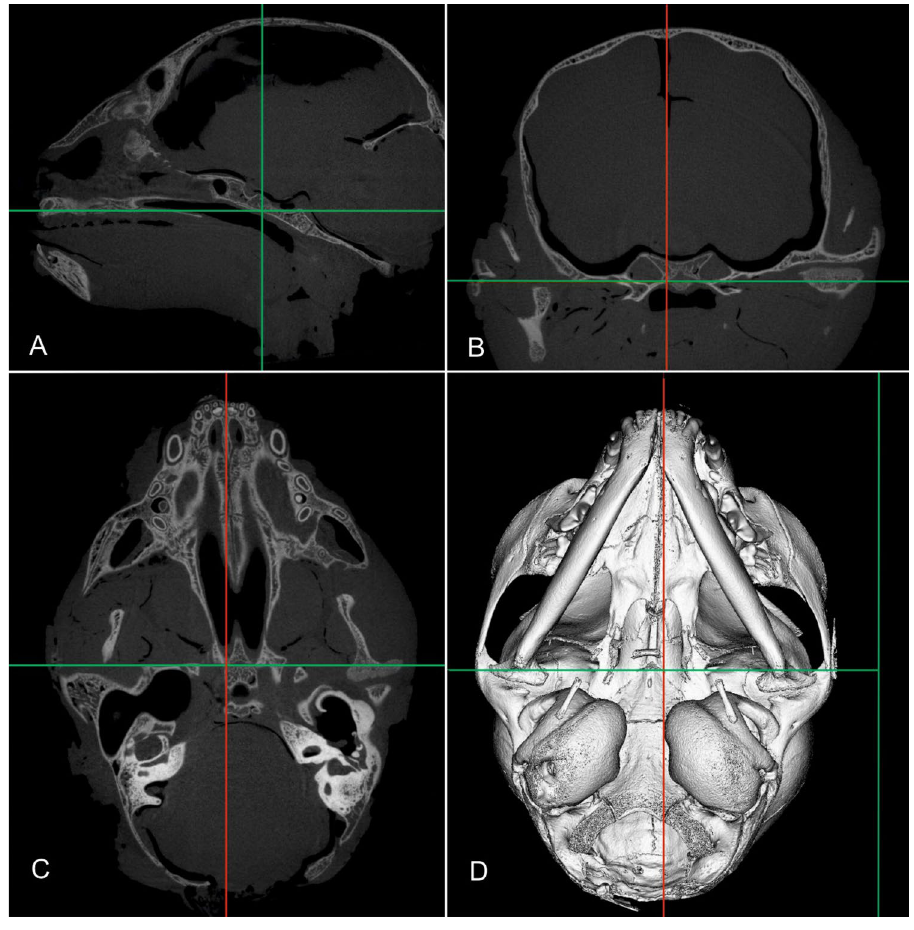
Figure 2. Combination of micro-CT images and a 3D head model of a 6-month-old Domestic Shorthair cat in a sagittal ( A ), transverse ( B ) and dorsal plane ( C ) in